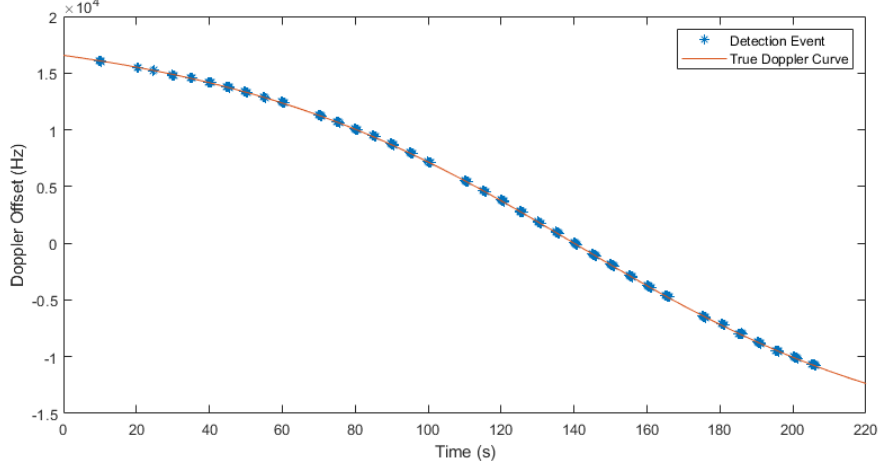
Figure 8. Detection results of burst mode transmission during a PROPCUBE